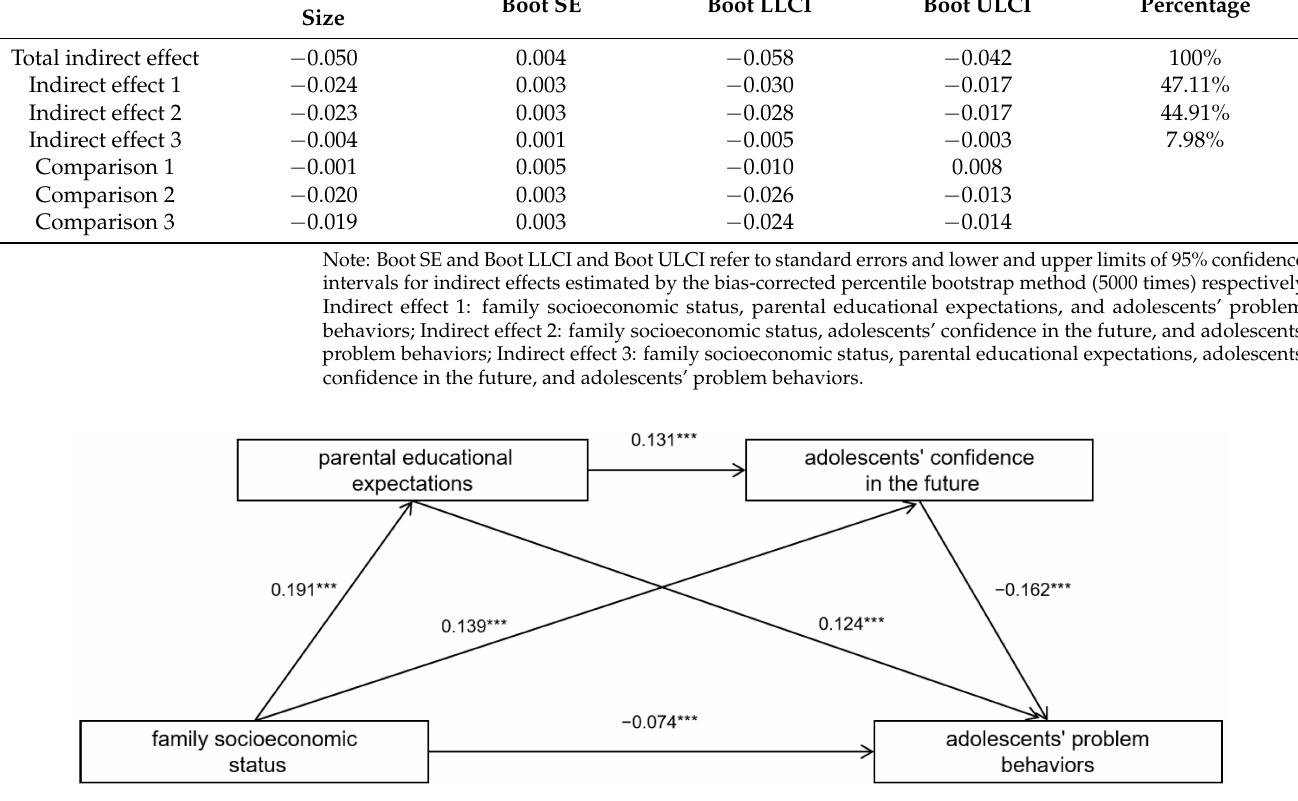
Figure 1. The path of multiple mediating effects. *** p <